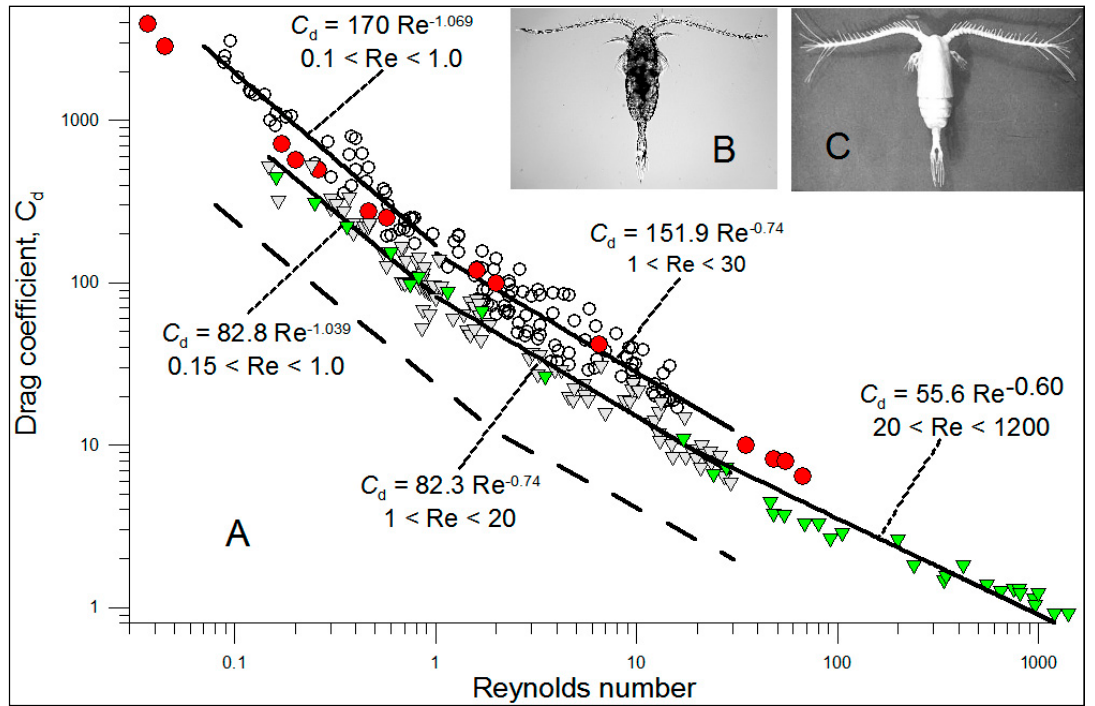
Figure 12. ( A ): Drag coefficient versus Reynolds number of 17 species of immobilized copepods (from [74]) when moving in water with open antennae ( ○ ) and antennae pressed to the body ( ∇ ). Red circles and green triangles indicate the C d of enlarged models when moving with spread and pressed antennas, respectively (from [72,73]). The dashed line shows C d of the sphere [75]. ( B , C ): Photos of immobilized calanoid copepod Paracalanus parvus and its enlarged (~1:100) model,